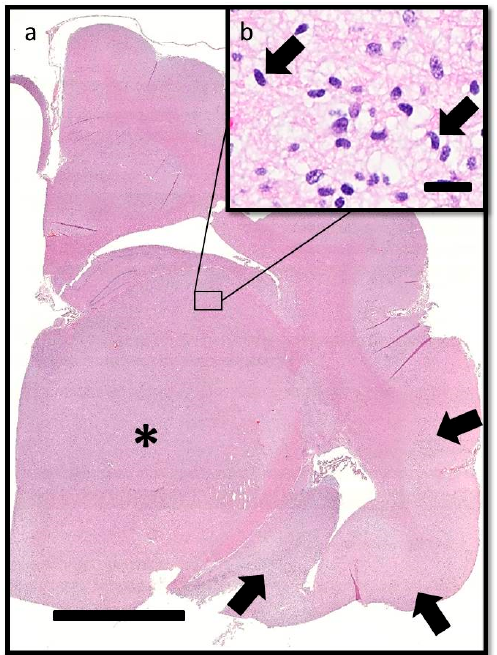
Figure 4. Transverse section of the brain at the level of the interthalamic adhesion. ( a ) Subgross photomicrograph showing loss of general anatomical detail within the thalamic nucleus and internal capsule due to a poorly delineated neoplastic mass (asterisk). Neoplastic cells also obscure the sylvian gyrus, hippocampus, and intervening parenchyma (arrows). HE. Bar = 5 mm. ( b ) Inset of ( a ). The neoplastic cells have indistinct cytoplasm, ovoid to elongated or curved hyperchromatic nuclei, and indistinct nucleoli (arrows). HE. Bar = 20 µ m.